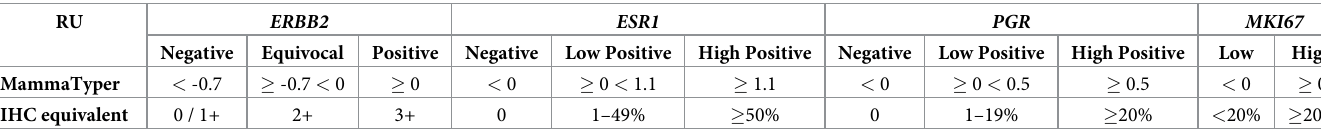
Table 2. Instrument-specific relative units (RU) for CFX96 TM (BIO-RAD 1 ) and the corresponding IHC equivalents.